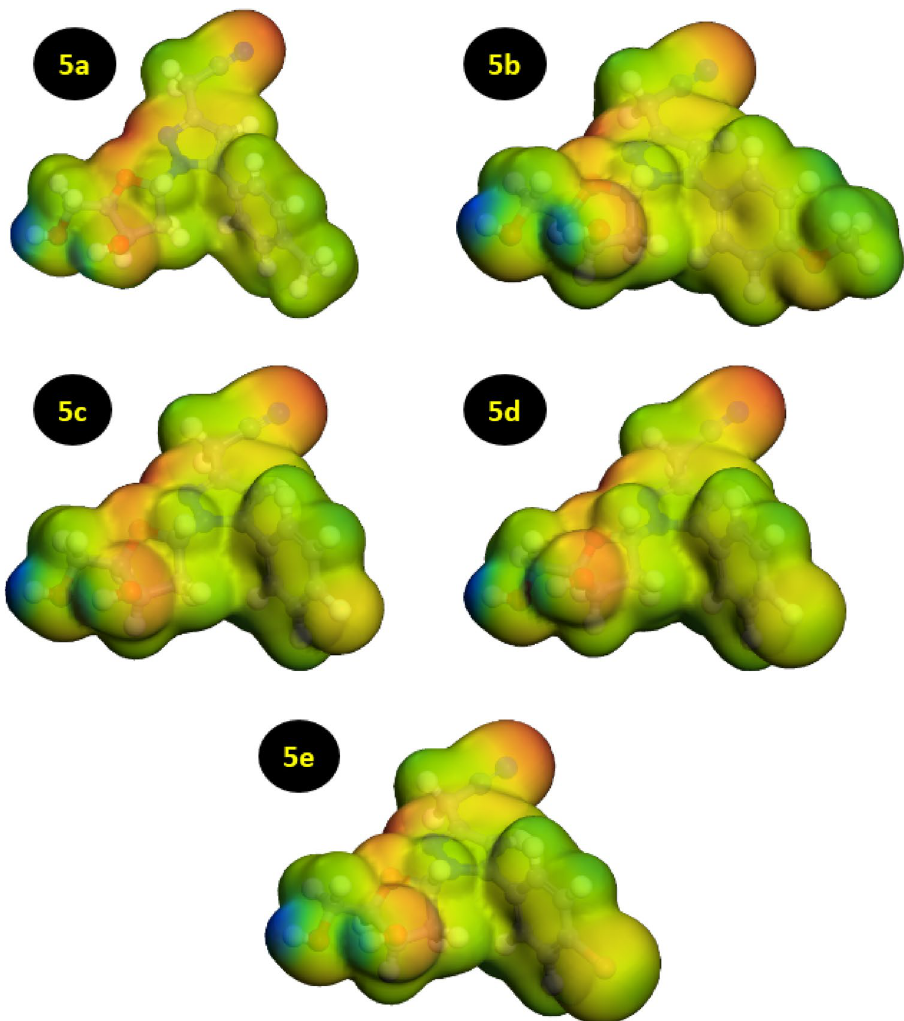
Figure 5. ESP graphic maps of the pyrazolylnucleosides 5a – e